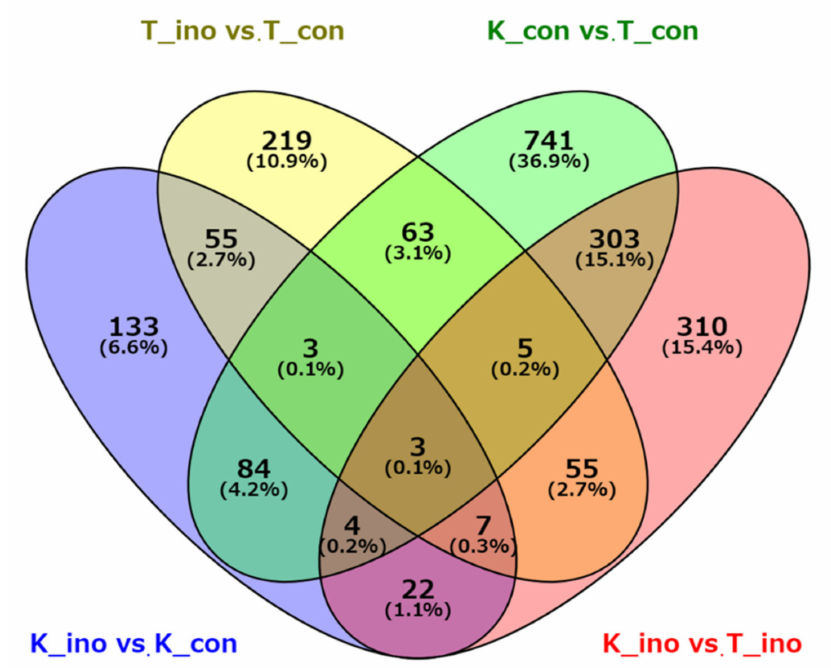
Figure 3. Venn diagram showing the number of DEGs and the overlaps among the four comparisons. Gene ontology (GO) analysis was performed using OmicsBox for the functional anno- tation of the identified DEGs between K166 and Tamayutaka at 30 days after inoculation. In the biological process category, the top two enriched GO terms for the set of genes upregulated in K166 were “metabolic process” and “cellular process”, followed by terms related to phosphorylation such as “phosphate-containing compound metabolic process”, “phosphorylation”, and “protein phosphorylation” (Figure 4a). In terms of